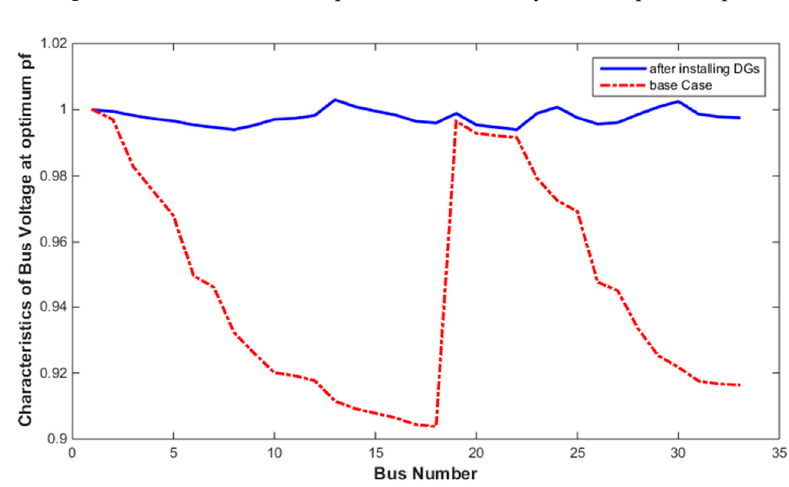
Figure 18. Characteristics of bus voltage, 33-bus at optimum pf.